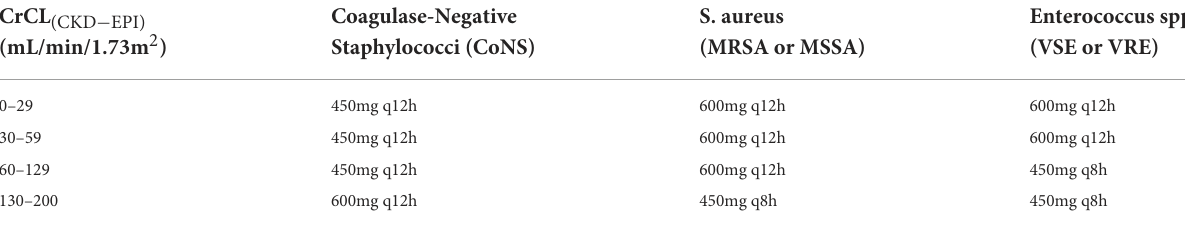
TABLE 1 Algorithm for determining the optimal linezolid dosage for overweight and obese patients. CrCL (CKD − EPI) Enterococcus